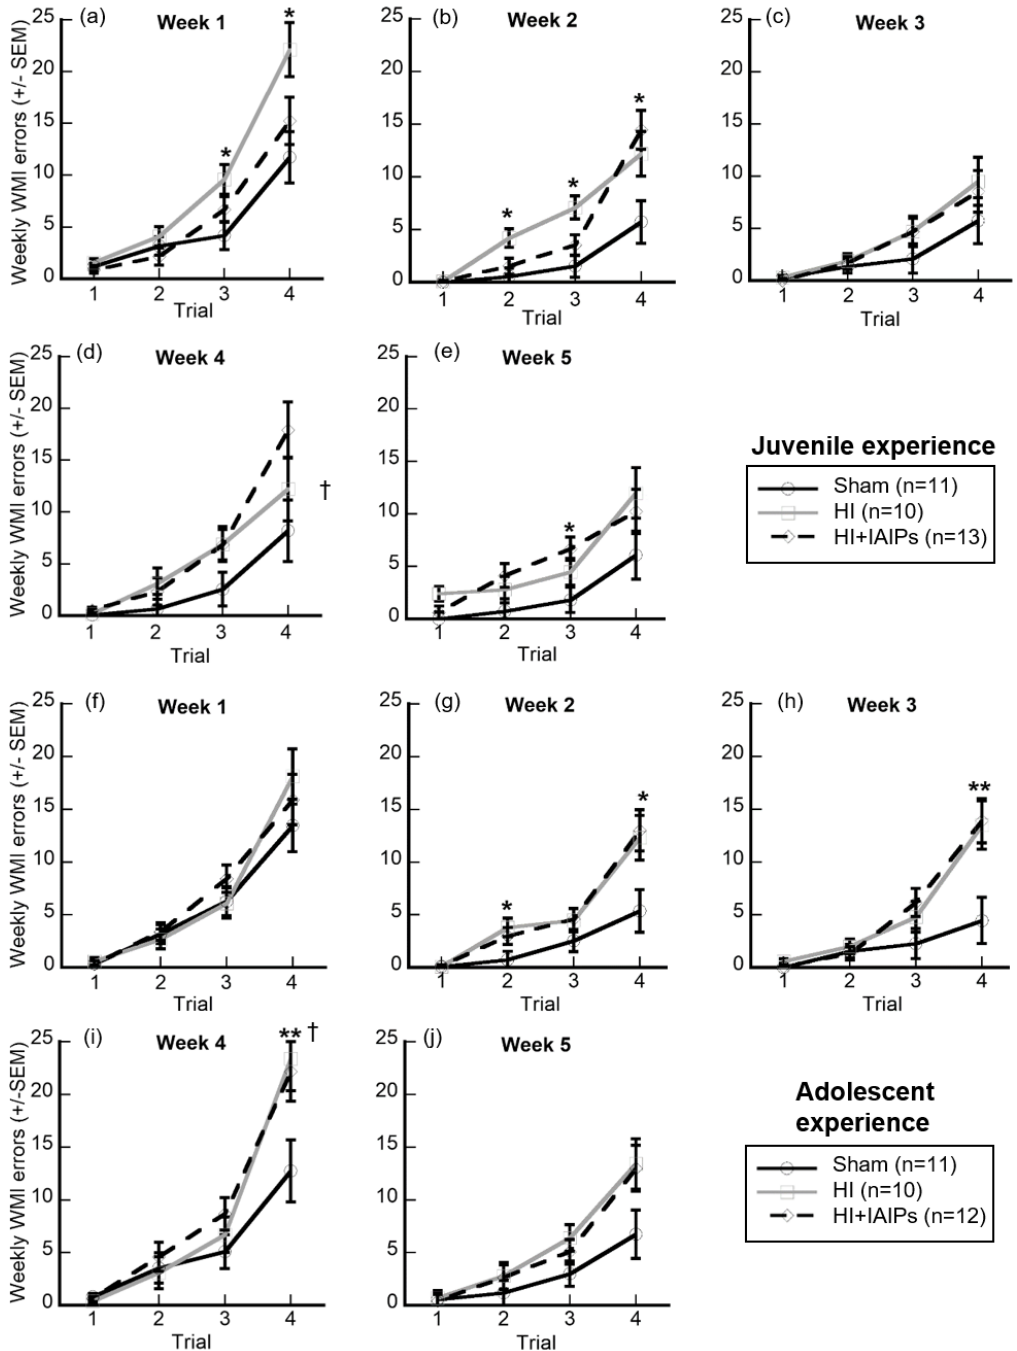
Figure 5. Expanded representation of WMI error performance ( ± SEM) on individual trials collapsed across weeks. Top two rows ( a – e ): juvenile first RWM experience starting at P31. Total n = 34, Sham (11), HI (10), HI + IAIPs (13). Bottom two rows ( f – j ): adolescent first RWM experience starting at P52. Total n = 33, Sham (11), HI (10), HI + IAIPs (12). Each plot is aligned by that experience group’s number of weeks of experience. A three-week break occurs between Week 3 and Week 4 for both experience groups. Paired comparisons were made between both treatments within each graph and between experience groups at the same relative trial, for example, Figure 5a,f. * indicates a trial where one injured treatment group, either HI or HI + IAIPs, performed significantly worse than Sham. ** indicates a trial where both HI and HI + IAIP treatment groups performed worse than Sham. † indicates a trial where the HI-treated, juvenile experience cohort ( d ) significantly differs from the HI-treated, adolescent experience cohort ( i ). All corrected by Sidak correction for multiple comparisons.